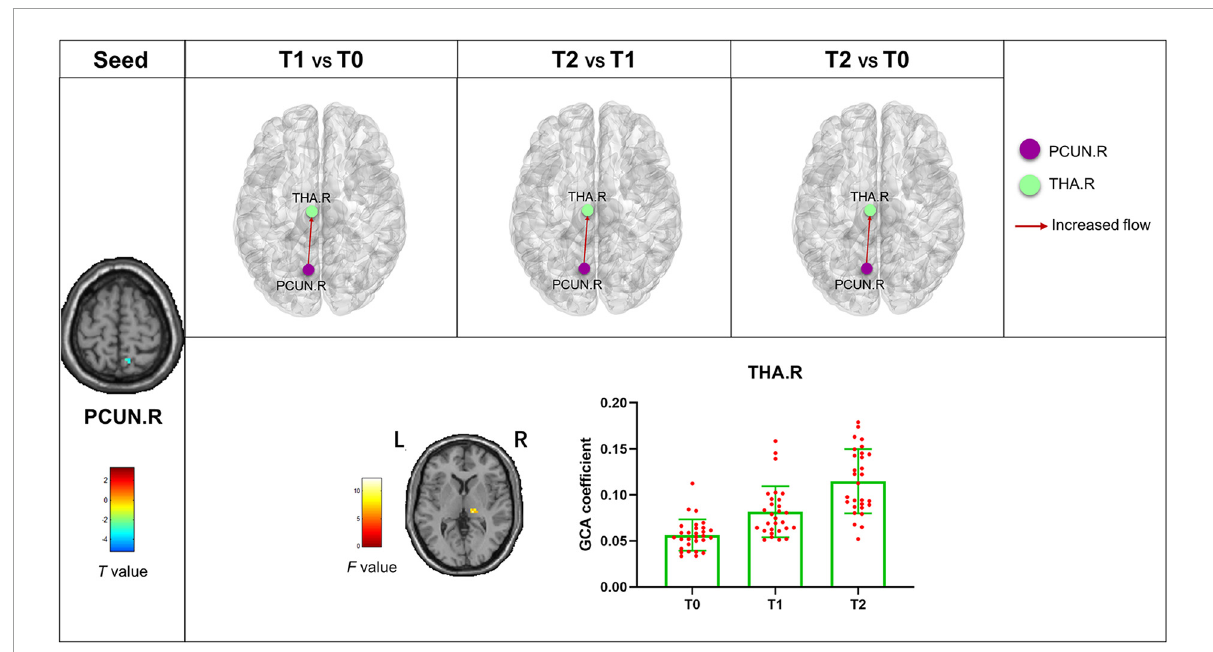
FIGURE6 Abnormal effective connectivity pathways associated with the PCUN.R. Each bar chart reflects the values of the dynamic GCA coefficient in the corresponding group. Fuchsia arrows indicate significantly enhanced DEC variability. T0, the time point at baseline; T1, the time point after the first acupuncture session; T2, the time point after the 12th acupuncture sessions. All abbreviations are defined in the Abbreviations section.